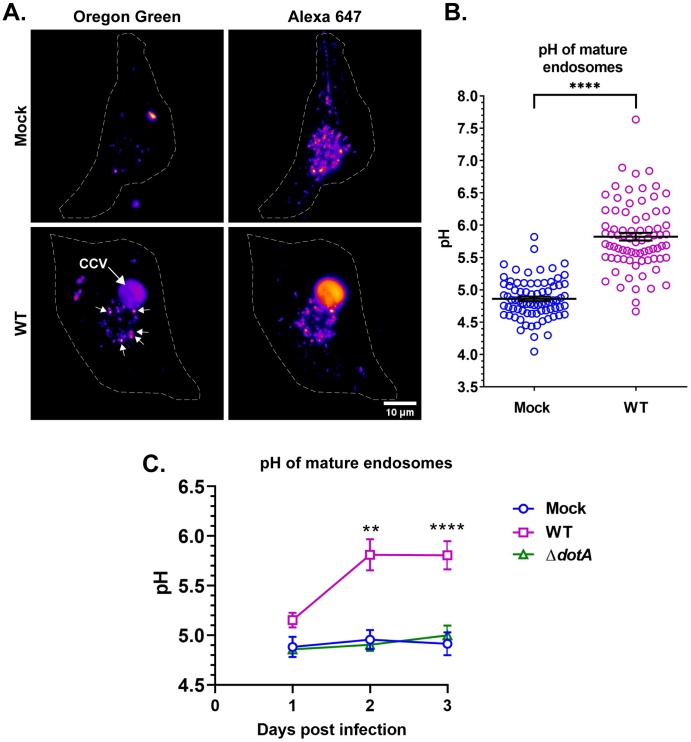
C. burnetii T4BSS manipulates endosomal pH in infected cells.(A) mCherry C. burnetii-infected HeLa cells were labeled with Oregon Green 488 and Alexa fluor 647 dextran for 4 h followed by a 1 h chase. Z-stacked images were processed identically in ImageJ and Oregon Green 488 and Alexa 647 intensity quantitated. A heat map of mock and WT C. burnetii-infected cells revealed that the endosomal Alexa 647 intensity was comparable between mock and infected cells. However, Oregon Green 488 was visibly brighter in the endosomes of the infected cells (arrows), suggesting that endosomes in infected cells are less acidic. (B) Ratiometric pH measurement revealed the pH of “mature” endosomes in WT C. burnetii-infected cells is ~ pH 5.8, compared to ~ pH 4.9 in mock-infected cells. Data shown as mean±SEM of at least 20 cells in each of three independent experiments as determined by unpaired student t-test; ***, P<0.001. (C) Mean endosomal pH in mock, WT, and ΔdotA-infected cells at 1 through 3 dpi revealed that the C. burnetii alters endosomal maturation beginning at 2 dpi. Data shown as mean±SEM of at least 15 cells per condition in each of three independent experiments as determined by one-way ANOVA with Tukey’s posthoc test; **, P<0.01; ****, P<0.0001.